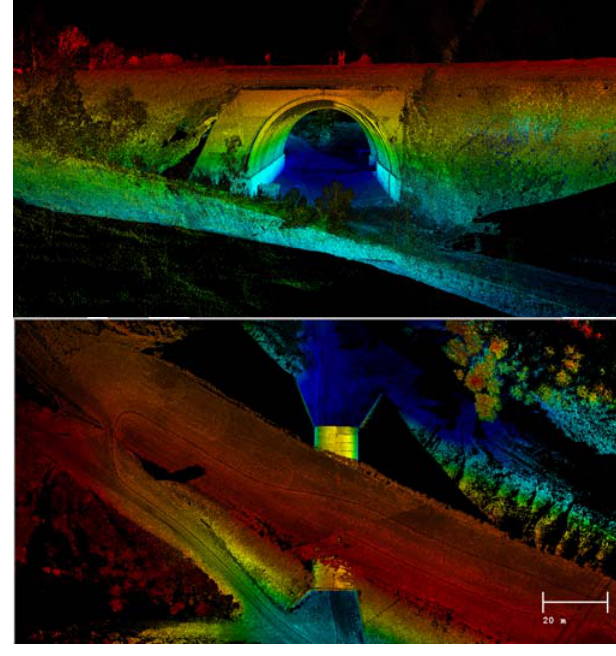
Figure 3. Geo-referenced point clouds of the underpass and the backfill (front and top view).